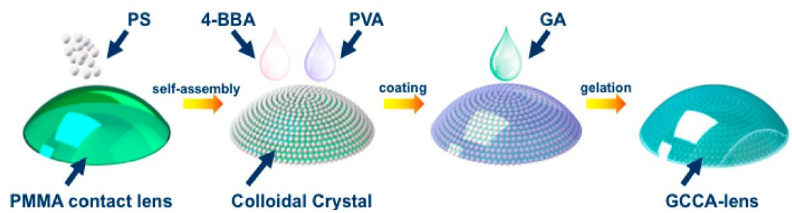
Figure 7. Preparation of glucose‐detected gelated CCA‐lens (GCCA‐lens). The polystyrene particles self‐assembled on the RGP contact lens and then a solution of 4‐boronobenzaldehyde‐modified poly(vinyl alcohol) (4‐BBA‐PVA) was coated on the colloidal crystal to form a gel. Finally, the gel was cross‐linked by the addition of glutaraldehyde (GA). Reproduced with permission [84]. Copyright 2017, MDPI AG.